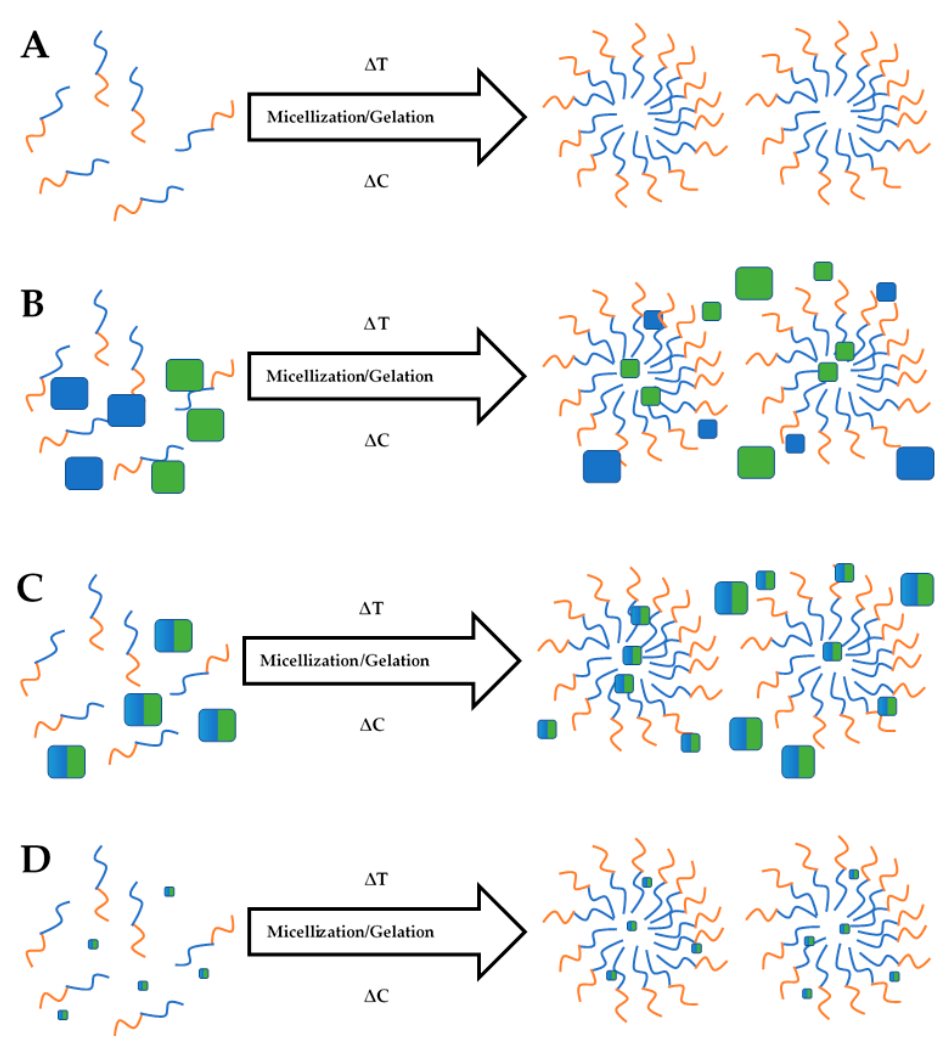
Figure 4. The process of micellization and subsequent gelation of the PF-127 system for control ( A ), pure active pharmaceutical ingredients (API)-loaded hydrogel ( B ), MCC-loaded hydrogel ( C ) and NCC-loaded hydrogel ( D ).